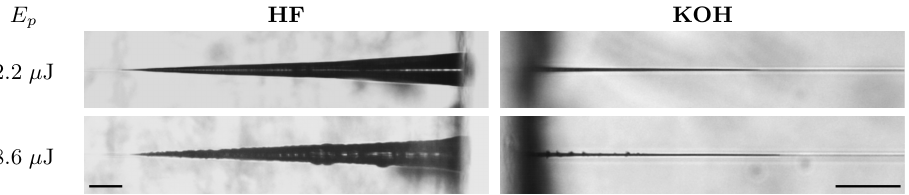
Figure 5. Examples of etched cones (top-view microscope pictures), obtained from tracks irradiated with orthogonal polarisation at two different inscription pulse-energies ( E p = 2.2 µ J and E p = 8.6 µ J), v t = 1 mm/s and 25 kHz repetition-rate. Etching was performed in HF solution for 10 min or in KOH for 6 h. Scalebars correspond to 50 µ m.